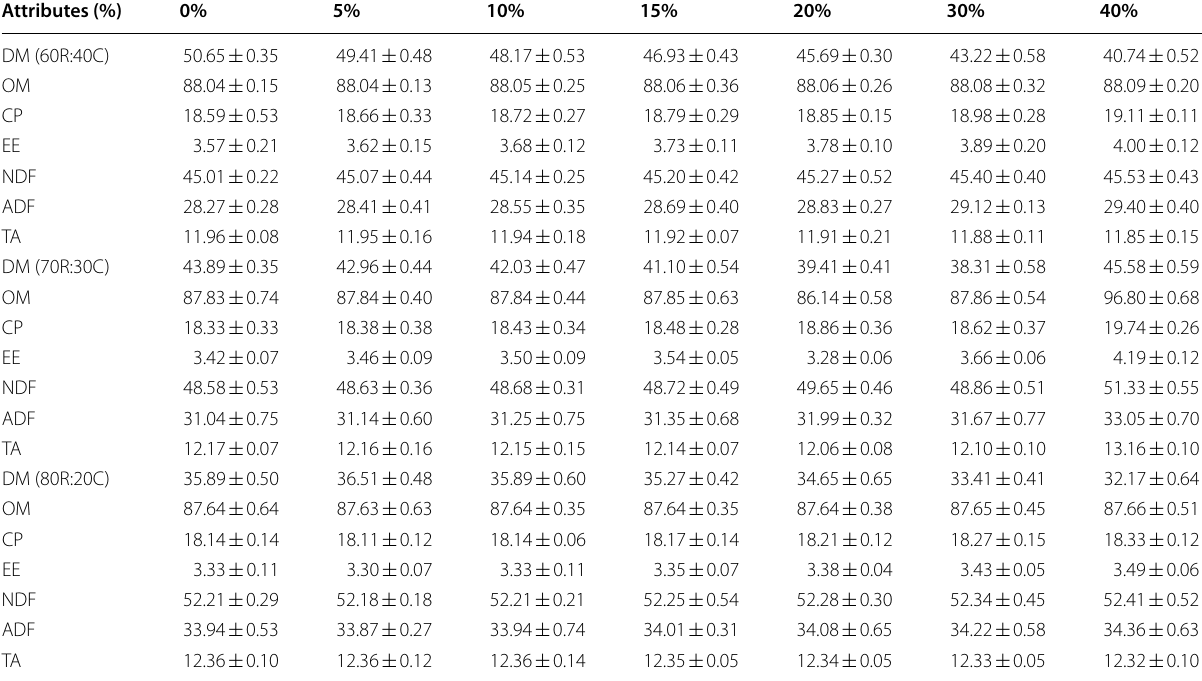
Table 1 Chemical composition (%) of total mixture ration in different groups (60R:40C, 70R:30C and